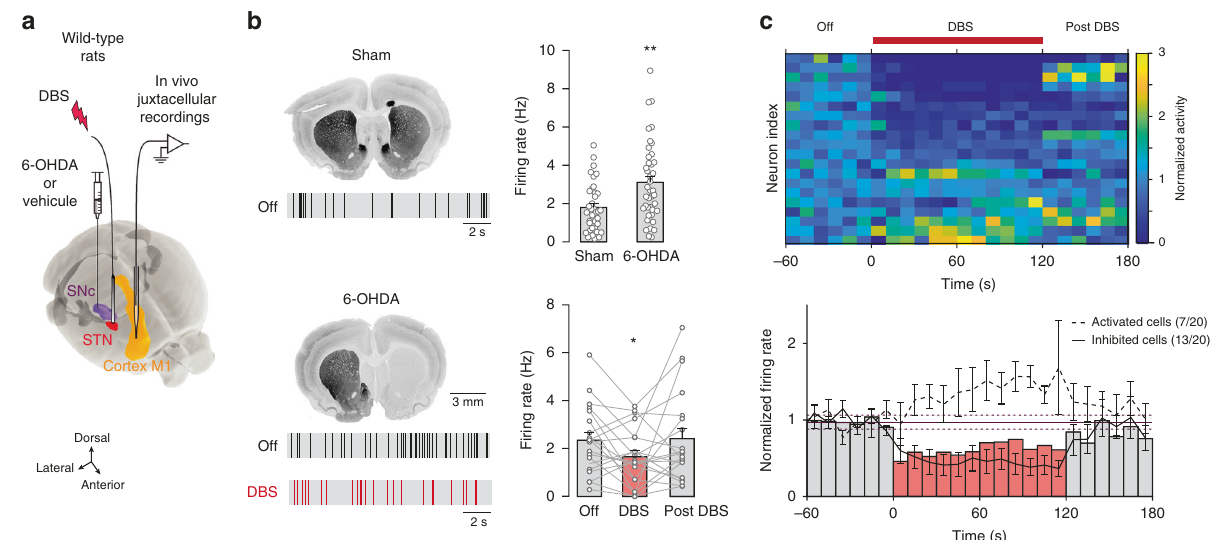
Fig. 1 DBS mediates in vivo inhibition M1 pyramidal cells in rats. a In vivo experimental set-up in anesthetized adult rats. b TH immunostaining and representative raster plots (15 s) of M1 neurons activity recorded in sham rats and in 6-OHDA-lesioned rats with or without DBS. Spontaneous activity of cortical neurons (mean ± SEM and individual neurons are represented) was higher in 6-OHDA-lesioned ( n = 41 neurons) compared to sham ( n = 36) rats ( p = 0.0014, t -test); DBS decreased the hyperactivity observed in 6-OHDA-lesioned rats (Off vs DBS: p = 0.0311, DBS vs Post: p = 0.0811, paired t -test, n = 20 neurons). c Heatmap of individual cortical neurons normalized fi ring rate (top), and averaged time course (bottom), before, during and after DBS (10s bins) in 6-OHDA-lesioned rat: bars correspond to the median of all neurons (mean ± 2×SD of the baseline is indicated) and separate time courses (mean ± SEM) for activated and inhibited neurons are superimposed. Under DBS, 65% of the pyramidal cells were inhibited while 35% were activated ( n = 20). All statistical tests are two-tailed. * p < 0.05; ** p < and morphological identi fi cation and used as ground truths for